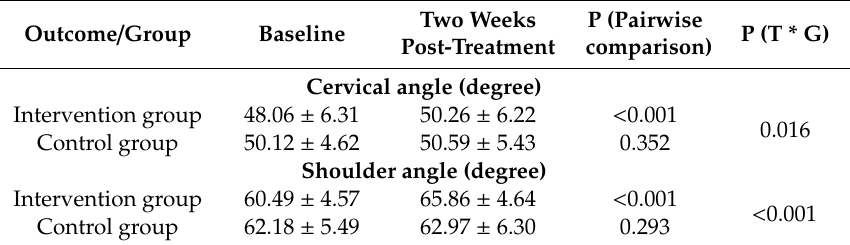
Table 4. The changes in cervical and shoulder